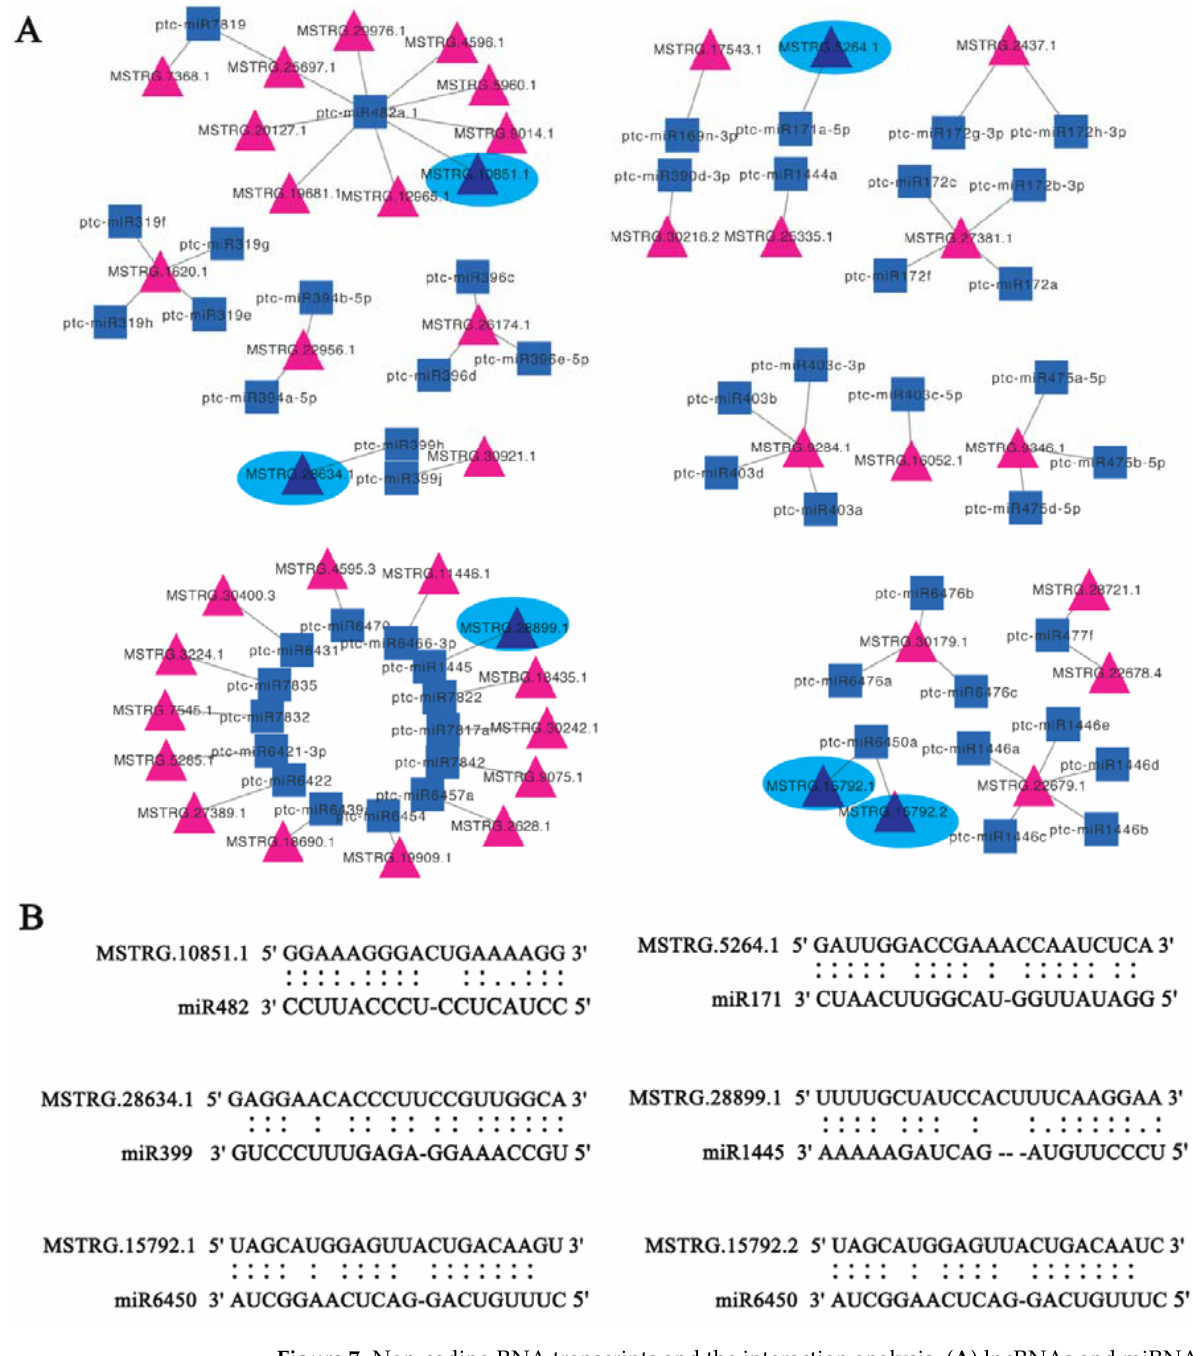
Figure 7. Non-coding RNA transcripts and the interaction analysis. ( A ) lncRNAs and miRNAs with interaction networks. ( B ) The lncRNAs targeted by miRNAs. Blue squares indicate miRNAs, red triangles indicate the lncRNA transcripts.